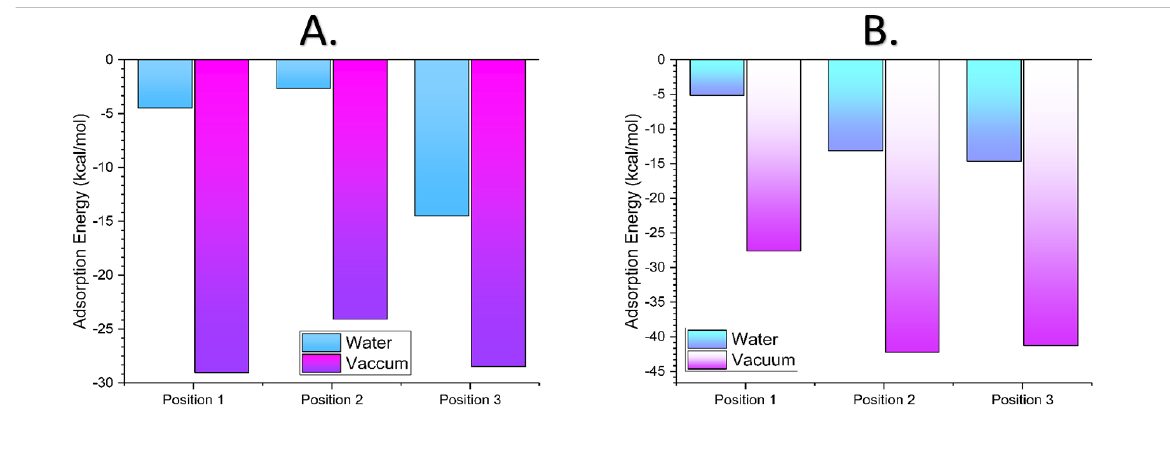
Figure 3: Adsorption energy of phenyldiazonium cation (in water and vacuum) at 3 different adsorption sites onto A. Graphyne and B.